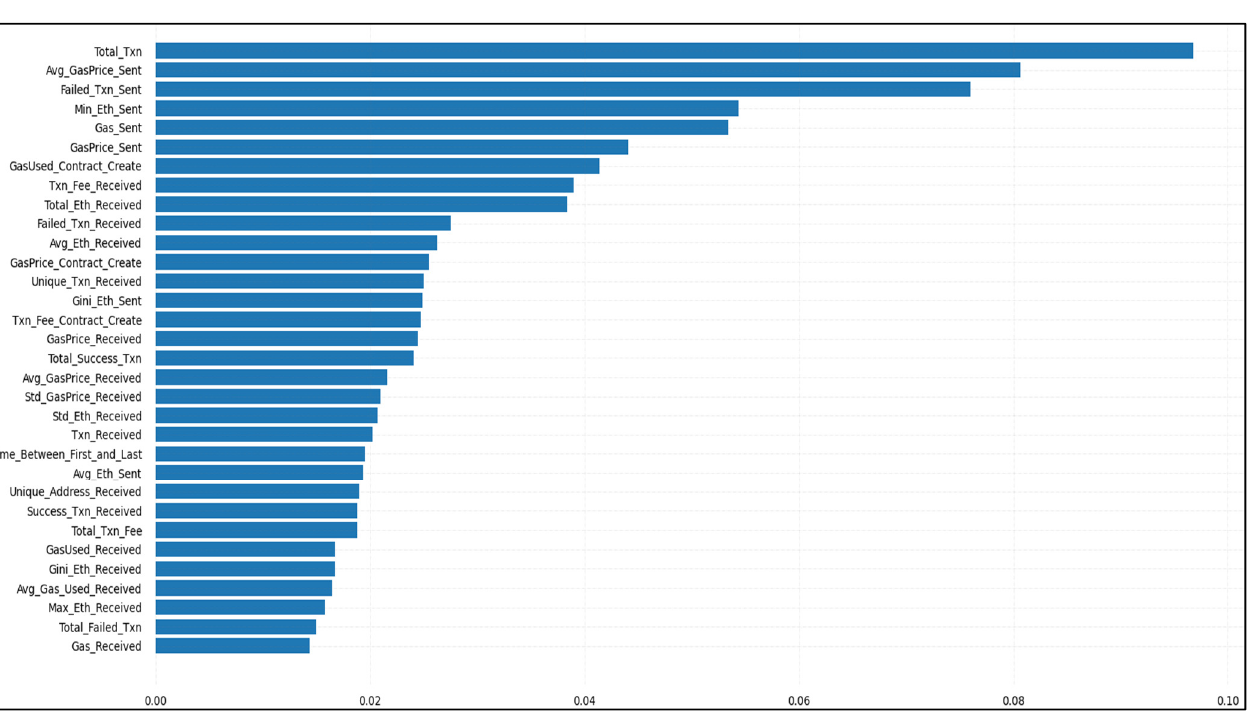
Figure 6. The ranking of the transaction features as determined by the XGBoost classifier.